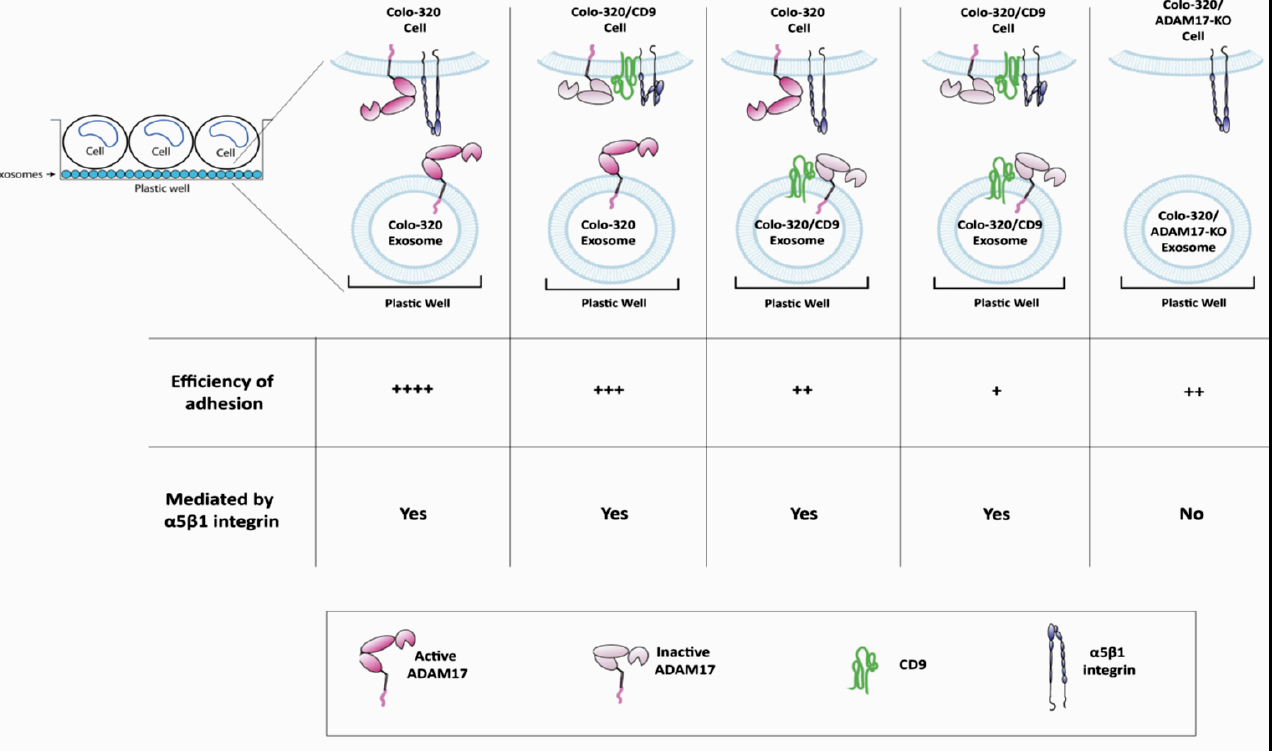
Figure 7. Schematic representation of the involvement of ADAM17, CD9 and integrin α 5 β 1 in interactions between exosomes and cells. The interaction of exosomes with cells was mediated by integrin α 5 β 1 in cells and ADAM17 in exosomes and was regulated by CD9. Cells adhered more efficiently to exosomes lacking CD9. Knocking-out ADAM17 expression in exosomes reduced cell − exosome interactions, which were no longer mediated by cellular integrin α 5 β 1. (Efficiency of adhesion is comparatively assigned: ++++ denotes highly efficient adhesion; +++ denotes efficient adhesion; ++ denotes less efficient adhesion; + denotes least efficient